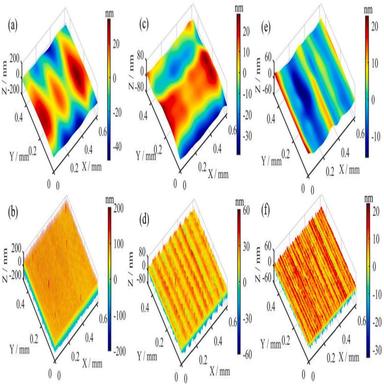
Surface filtering of the primary surfaces in (a, d, and g) by DWT at the machining conditions of: I - (a) the form components and (b) the S–F surfaces, II - (c) the form components and (d) the S–F surfaces, and III - (e) the form components and (f) the S–F surfaces.